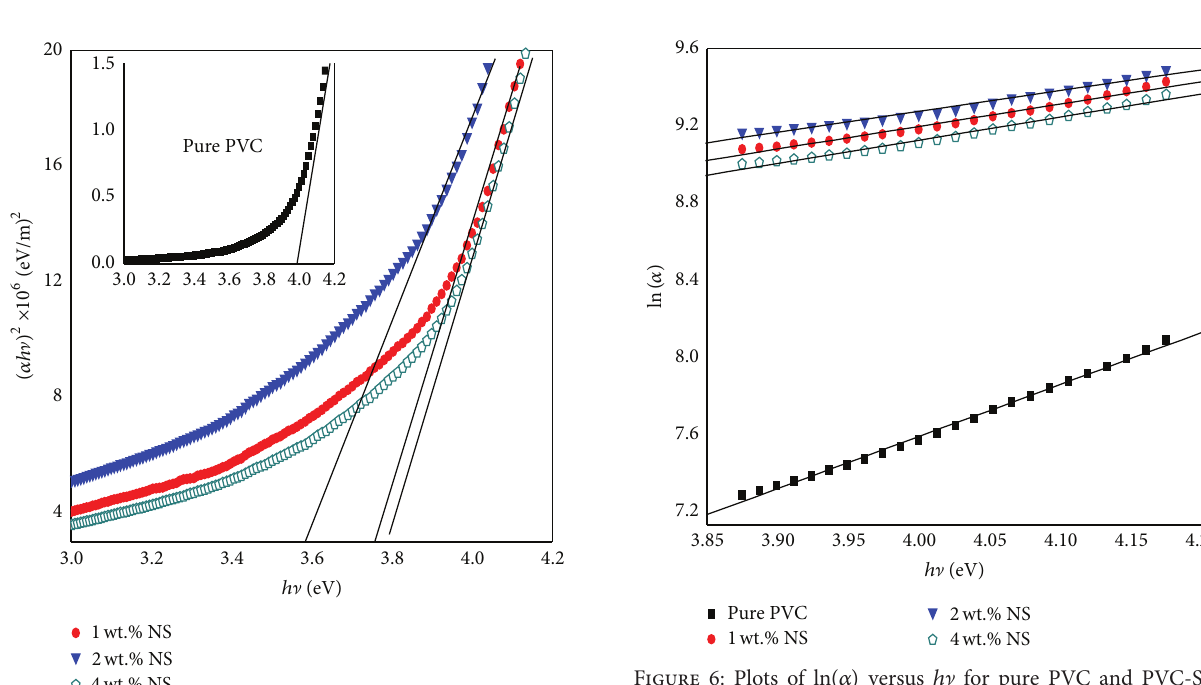
Figure 6: Plots of ln (𝛼) versus ℎ ] for pure PVC and PVC-SiO 2 nanocomposite films.